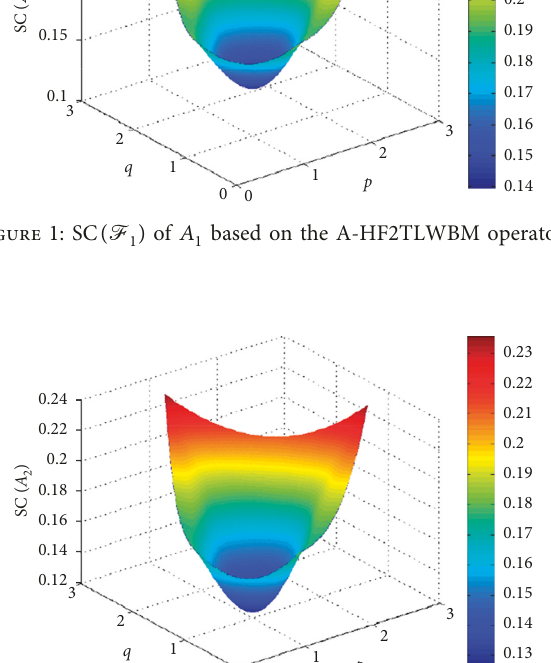
) of A based on the A-HF2TLWBM operator. 2 2